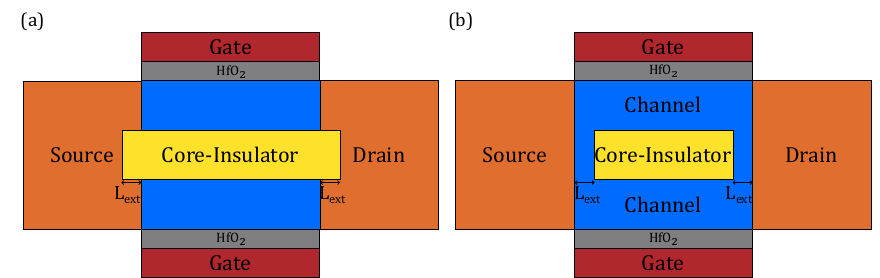
Figure 10. The illustrations which show the issue of Core–Insulator’s extension and contraction: ( a ) the Core–Insulator extends itself into source and drain by L ext ; ( b ) the Core–Insulator recesses itself into channel by L ext